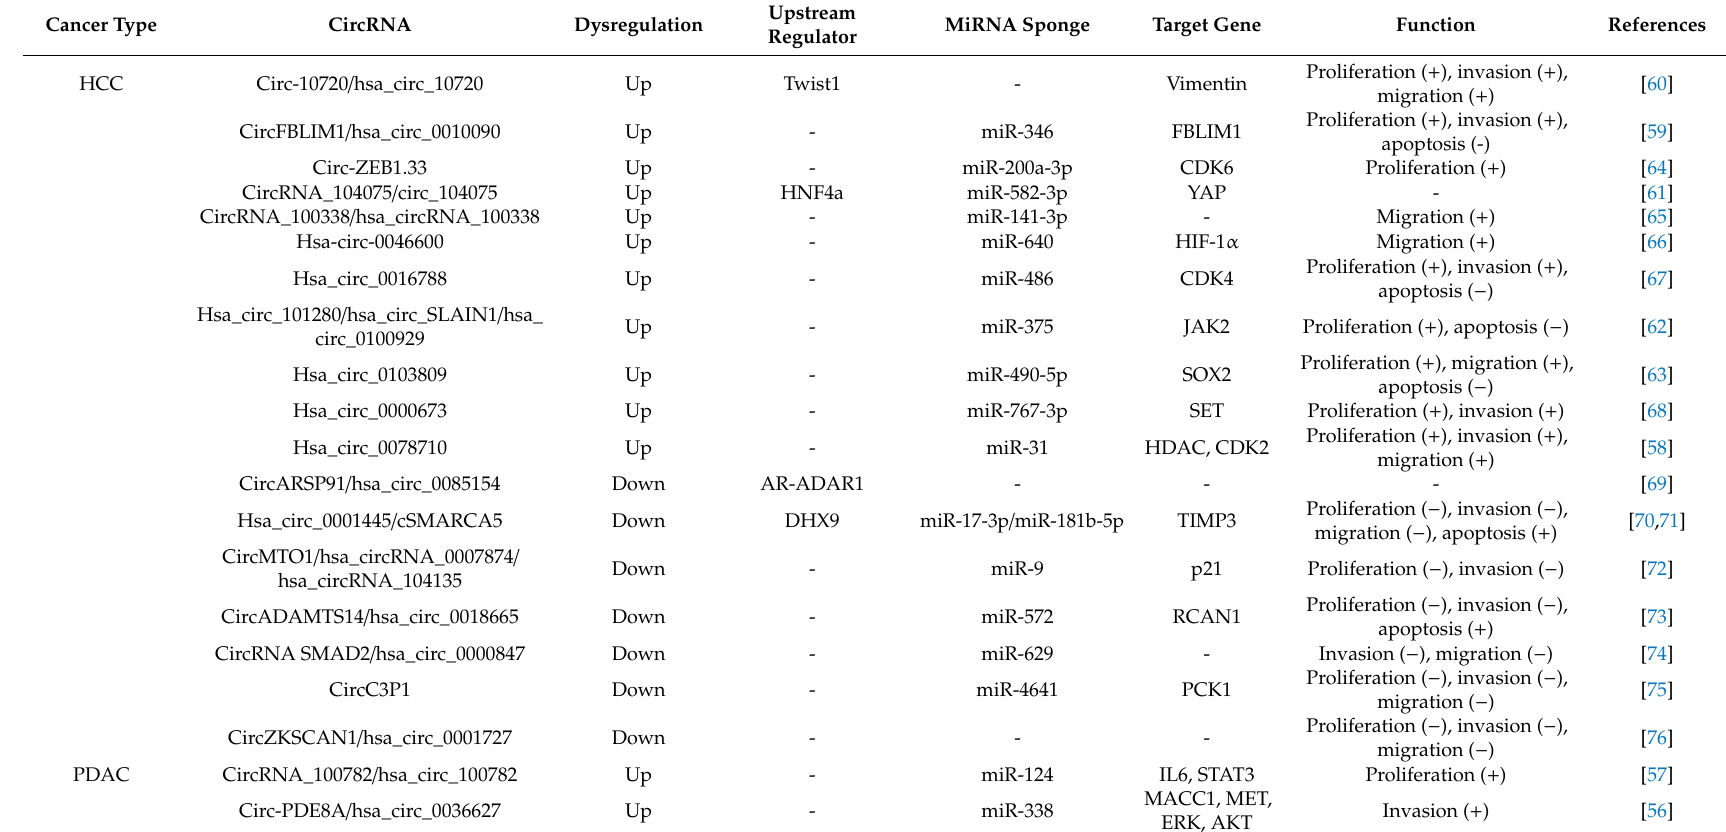
Table 3. CircRNAs in digestive gland